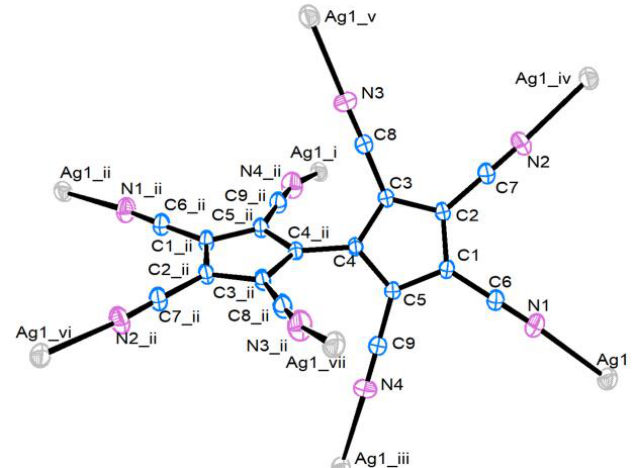
Figure 6. The octacyanofulvalenediide dianion with its eight coordinated Ag + ions.